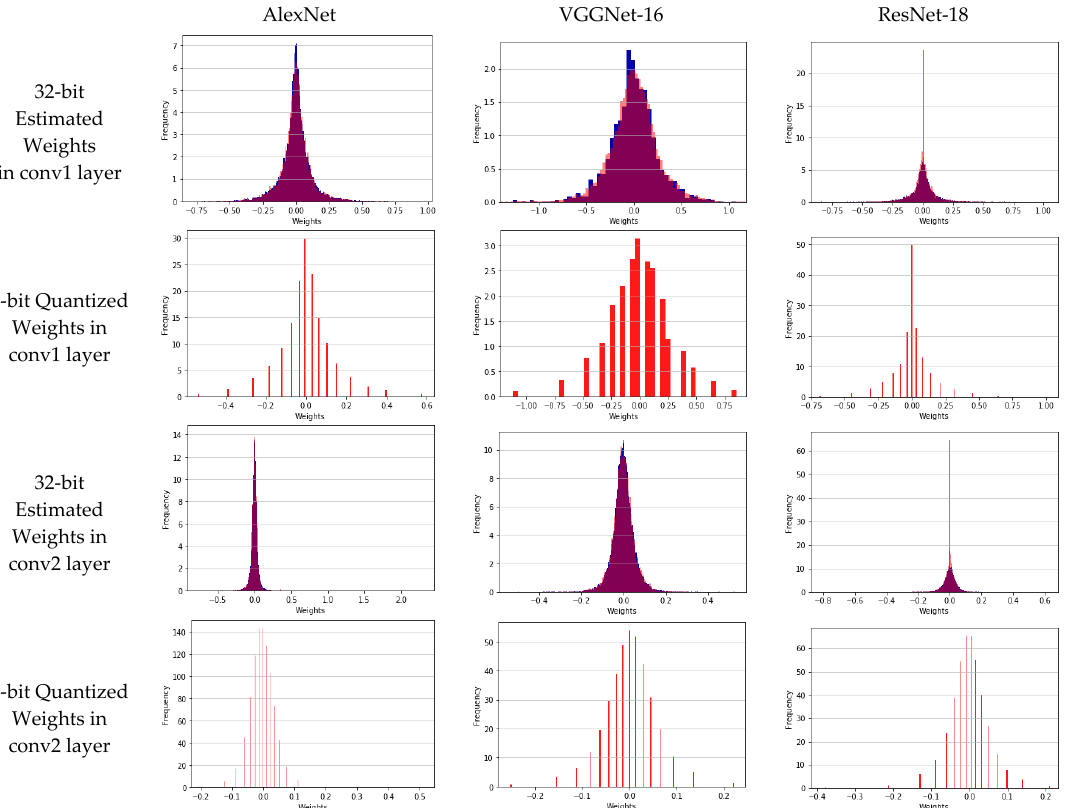
Figure 3. Visualization of estimated weights and quantized weights in the first two convolutional